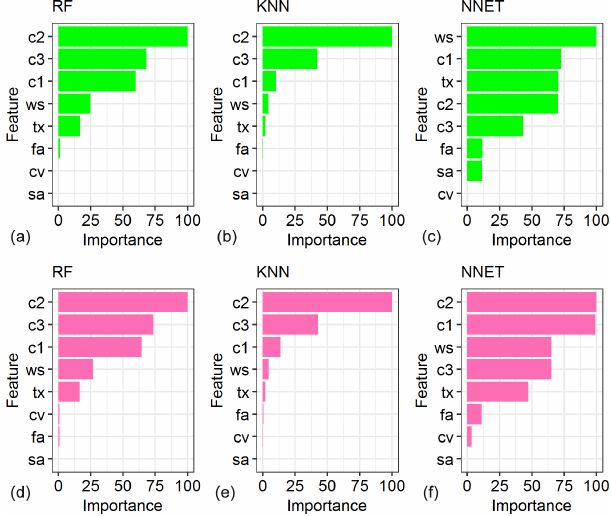
Figure 7. Relative importance of the hydrological model parame- ters based on the three machine-learning models, i.e. RF, KNN, and NNET, trained for pLoA (a–c) and Score (d–f)